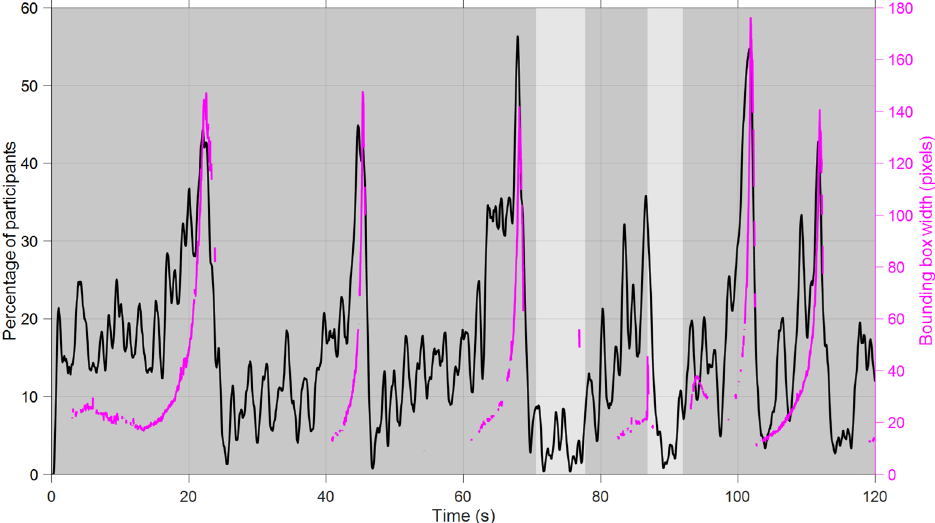
Figure 8. Left axis (black): Percentage of participants with their eyes on the left mirror (Video 2; three tasks averaged). Right axis (magenta): Width of the bounding box of the detected vehicle in the left mirror. The shaded background indicates whether the ego-vehicle was driving on the right lane (dark gray) or left lane (light gray).